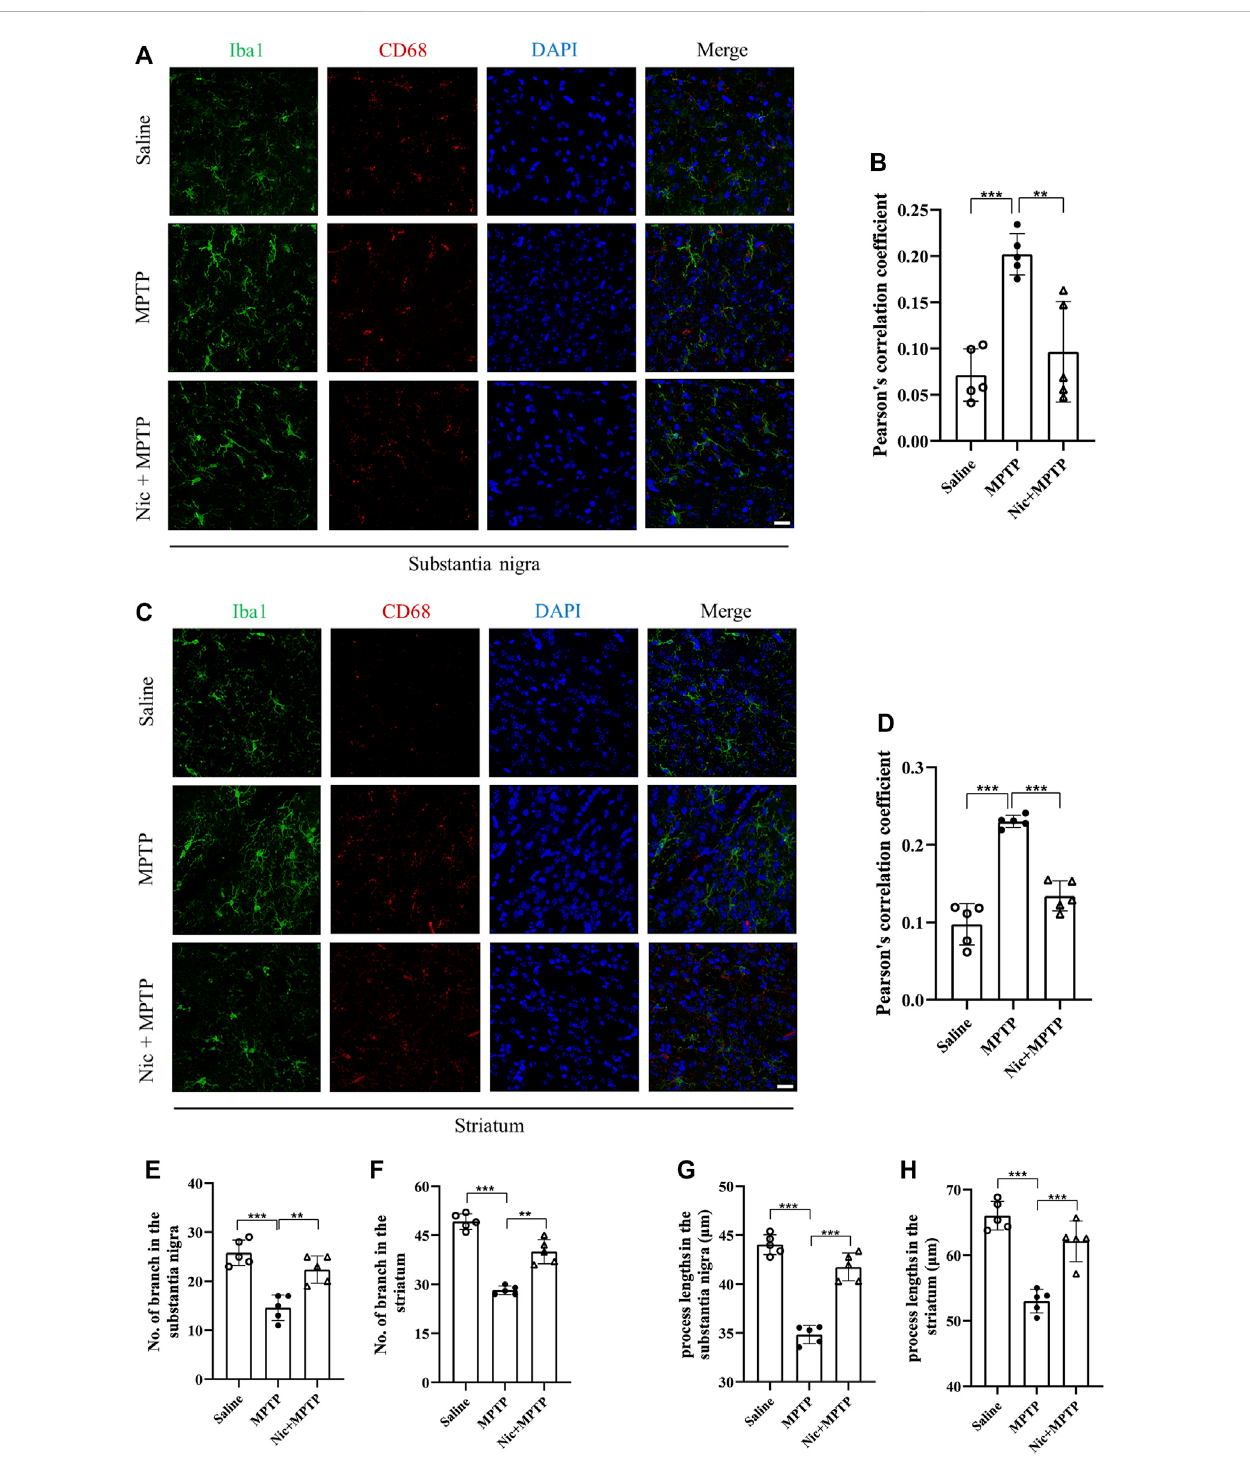
FIGURE 4 Nicotine inhibits the activation of MPTP-treated mouse substantia nigra and striatal microglia iba1 and the pro-in fl ammatory factor CD68. (A) Immuno fl uorescence histochemical staining in the substantia nigra. (B) Statistical results of colocalization of Iba1 with CD68 in the substantia nigra. (C) Immuno fl uorescence histochemical staining in the striatal regions. (D) Statistical results of colocalization of Iba1 with CD68 in the striatal regions. (E,F) Statistical results of microglia branching in the substantia nigra and striatal regions. (G,H) Statistical results of microglial process lengths in the substantia nigraandstriatalregions.Scalebarat20 μ m.Dataareexpressedasmean±SEMfrom fi vemiceineachgroup,everypointonthegraphisanaveragefromfour fi xed fi eldsofviewforeachmouse.Signi fi cantdifferencesweredeterminedbyanunpairedStudent ’ st-testandone-wayANOVAfollowedbyTukey ’